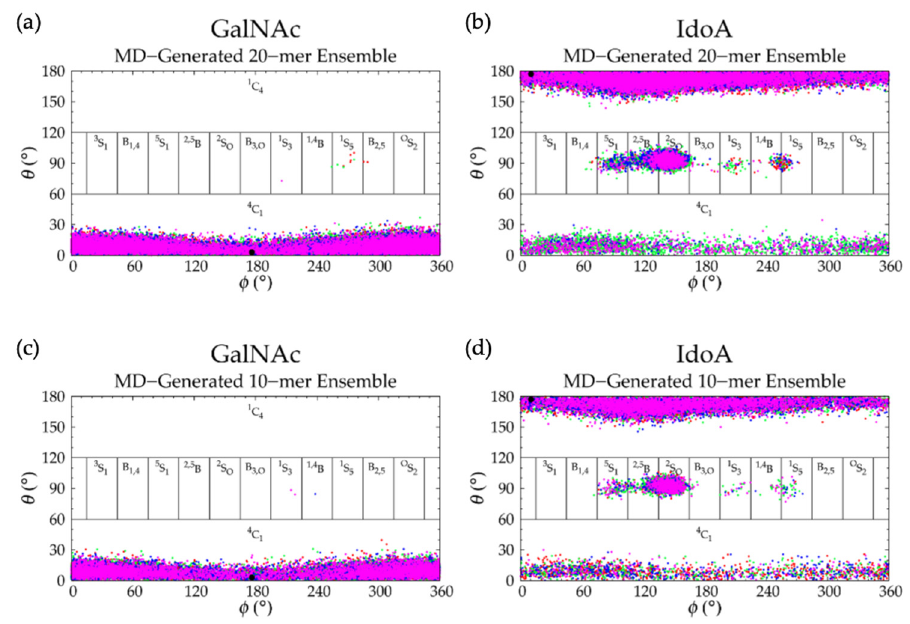
Figure 9. Cremer–Pople data for MD-generated nonsulfated dermatan ensembles: ( a ) GalNAc and ( b ) IdoA in the 20-mer and ( c ) GalNAc and ( d ) IdoA in the 10-mer; geometries from the four sets of each ensemble are represented by red, green, blue, and magenta dots, respectively and the force-field geometry is represented by a single large black dot; Cremer–Pople parameters ( φ , θ ) for all rings in every tenth snapshot from each ensemble were plotted (i.e., 10 rings × 1000 snapshots per run × 4 runs = 40,000 parameter sets for the 20-mer and 20,000 parameter sets for the 10-mer). IdoA monosaccharide rings in 20-mer MD sampled a majority of 1 C 4 and, to a lesser degree, 2 S O